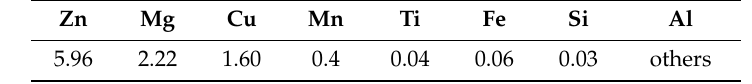
Table 1. Chemical composition of Al–Zn–Mg–Cu alloy in this research (mass fraction / %). Zn